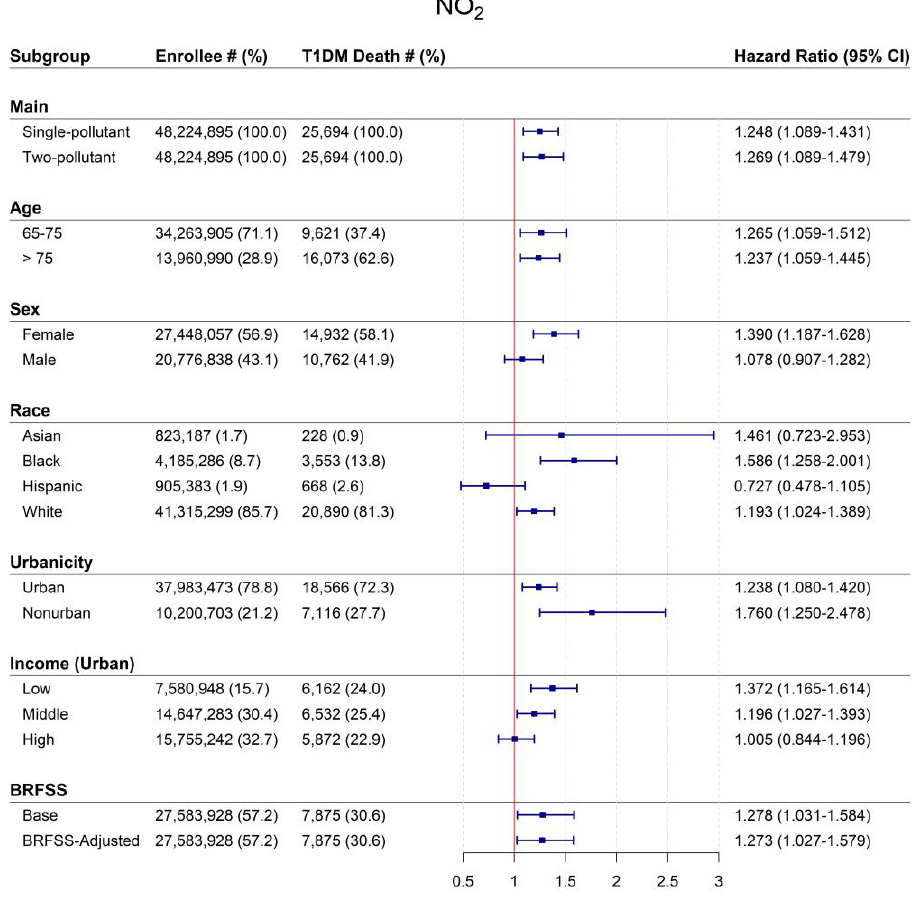
Figure 2. Mortality hazard ratios (95% CI) associated with a 10 ppb increase in 12-month average NO 2 for entire population and by subgroup, US 2001–2008. Abbreviations: CI = confidence interval; NO 2 = nitrogen dioxide; T1DM = type 1 diabetes mellitus. BRFSS data were not available for all the Medicare participants included in our full analyses. As such, the sample size for these sub-analyses is